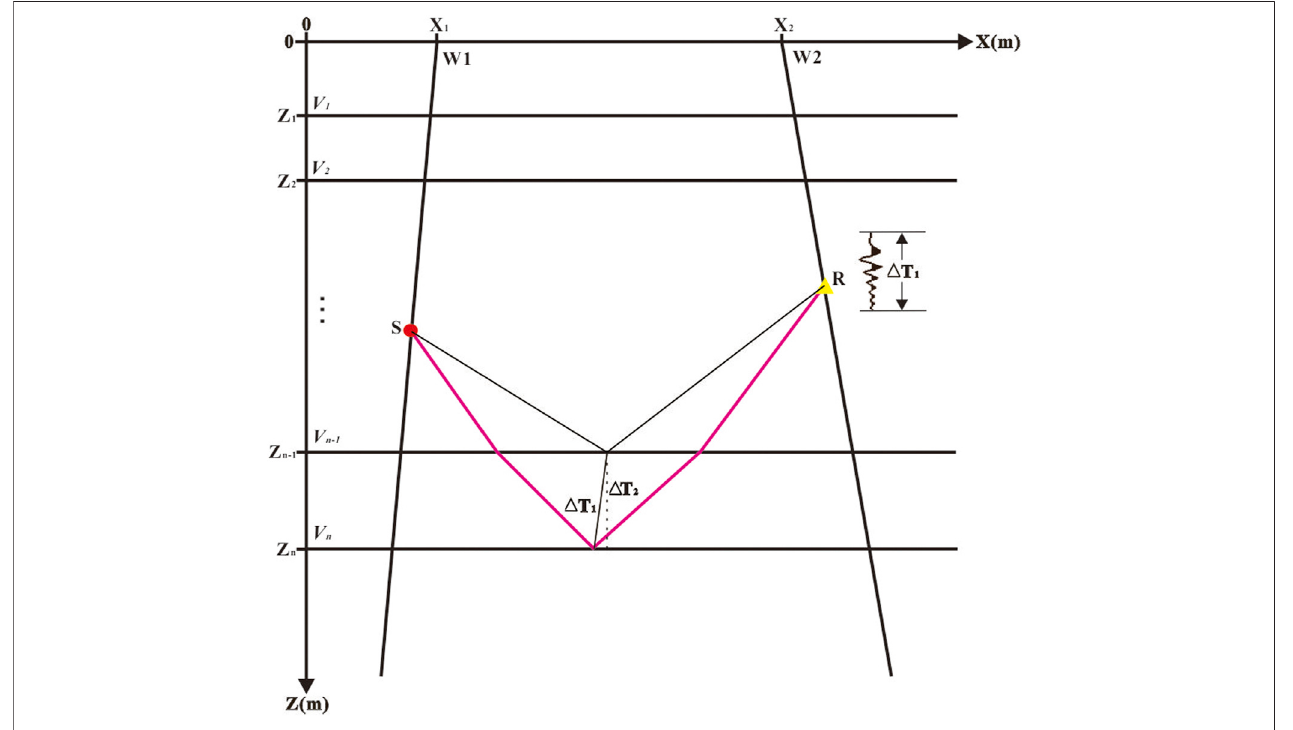
FIGURE 2 | Schematic diagram of XSP-CDP wave fi eld conversion.